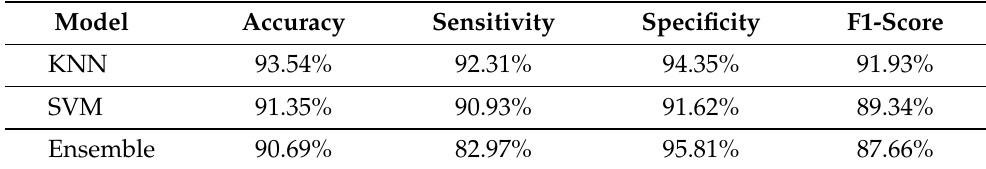
Table 1. Classification performance to distinguish between NTS and HTS individuals for the best models analyzed with the selected